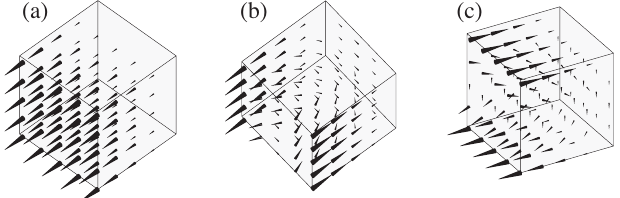
FIG. 2. The three shape functions per face proposed for the iron magnetization: the facet function (a) and the two recirculating functions (b) and (c).